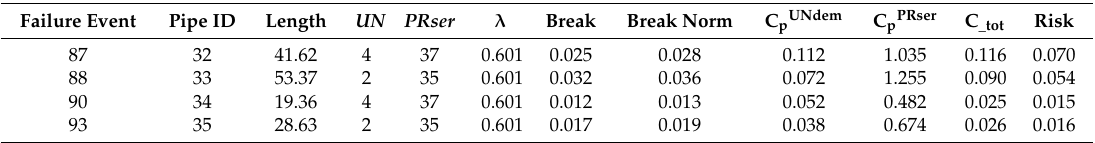
Table 2. An extract of risk calculation based on Eq. 3